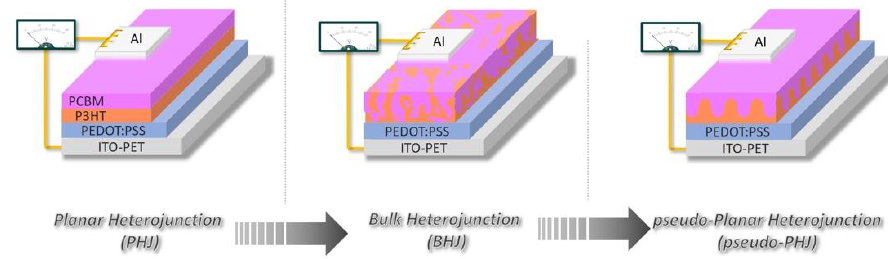
Figure 1. Schematics of the PHJ, BHJ, and pseudo-PHJ architectures for